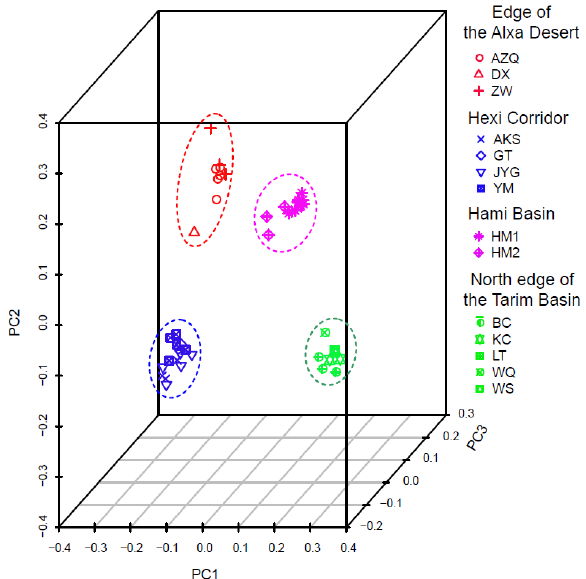
Figure 4. Principal components analysis (PCA) plots of 44 individuals from 14 sampled Gymnocarpos przewalskii populations based on the first three principal components. The dash lines show the four population groups.